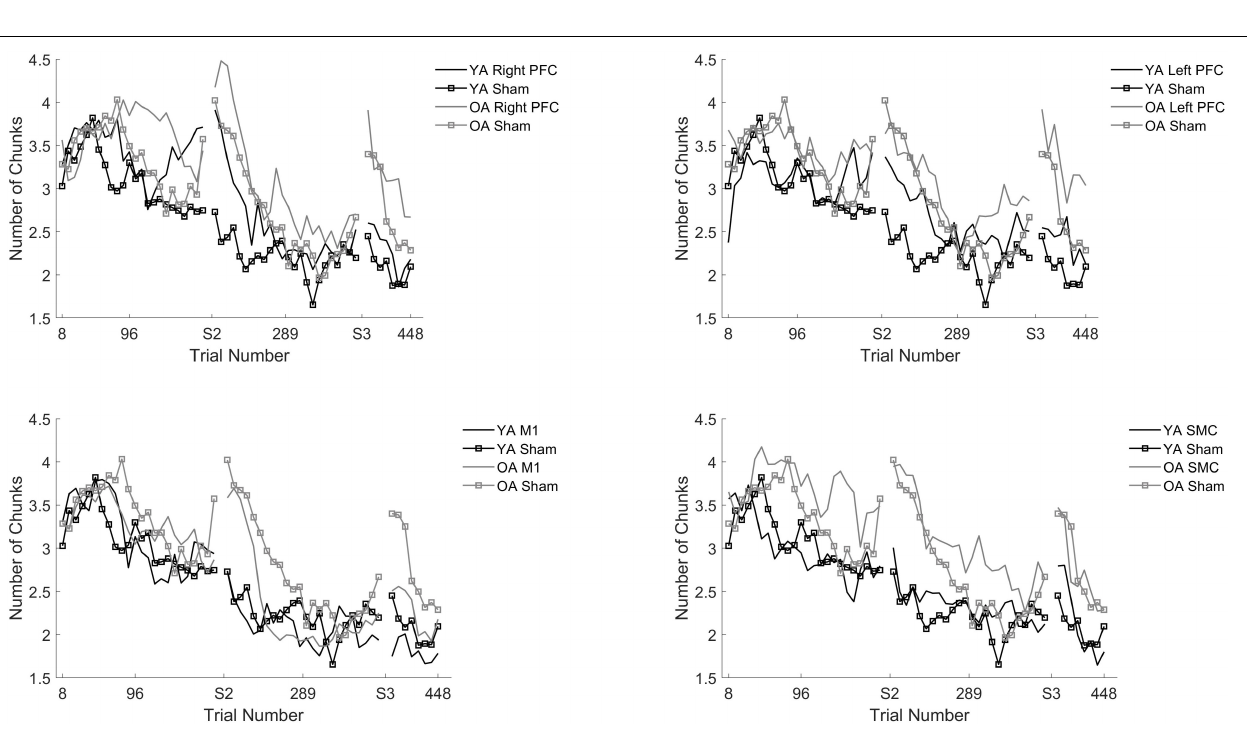
Frontiers in Human Neuroscience |